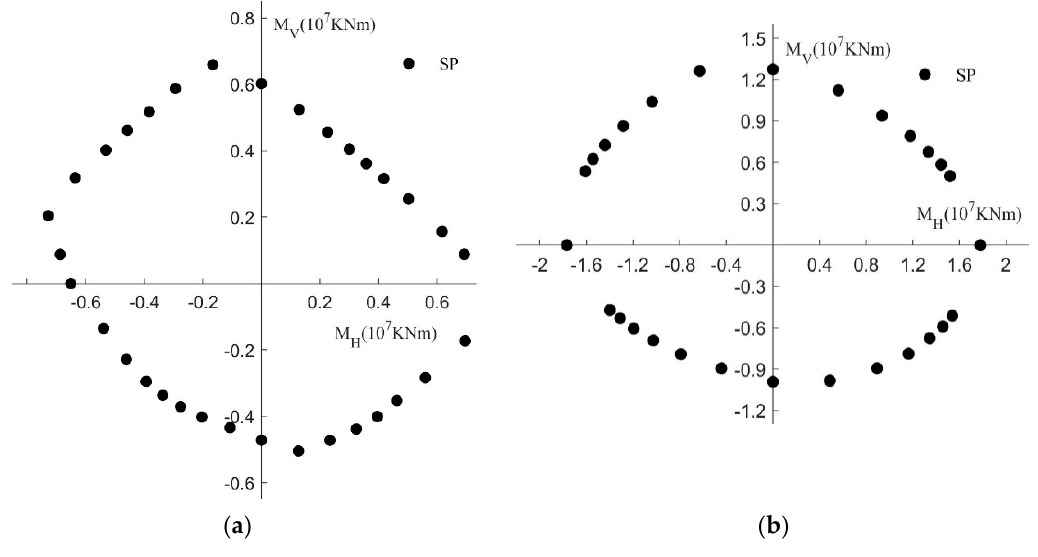
Figure 9. Distribution of sample for ( a ) DB and ( b ) DT.